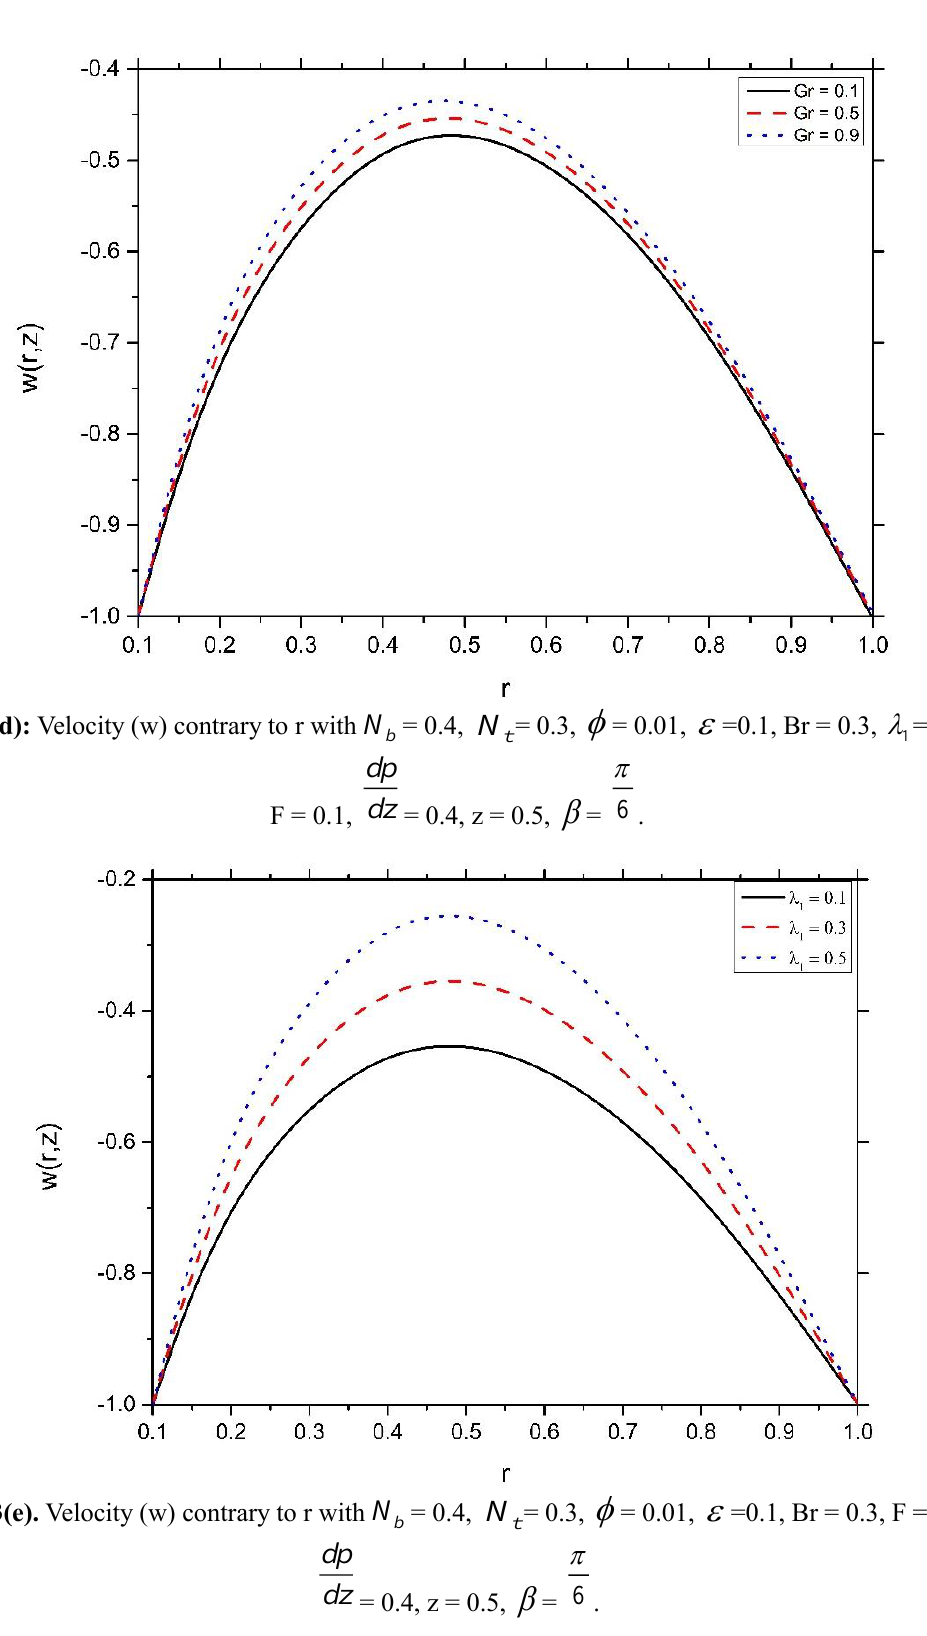
Fig. 3(e). Velocity (w) contrary to r with